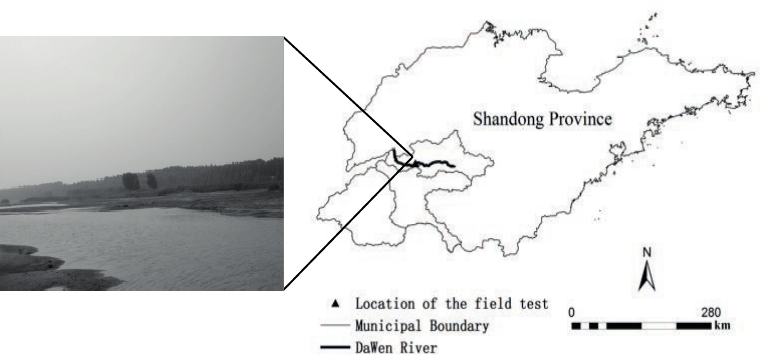
Fig. 1 Location of the test site in Shandong